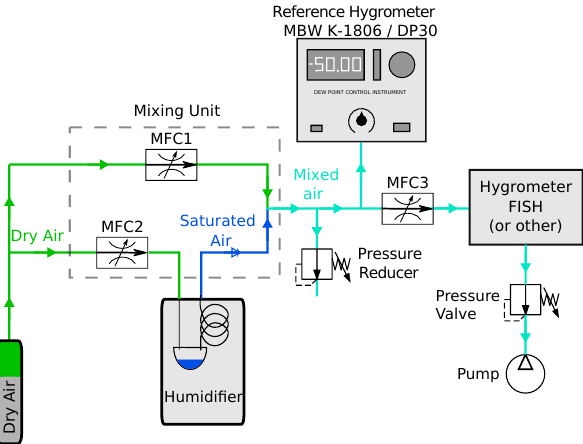
Figure 2. Conceptual diagram illustrating the principal mechanical and optical components of the FISH. The size of the cell is 0.3L in total.